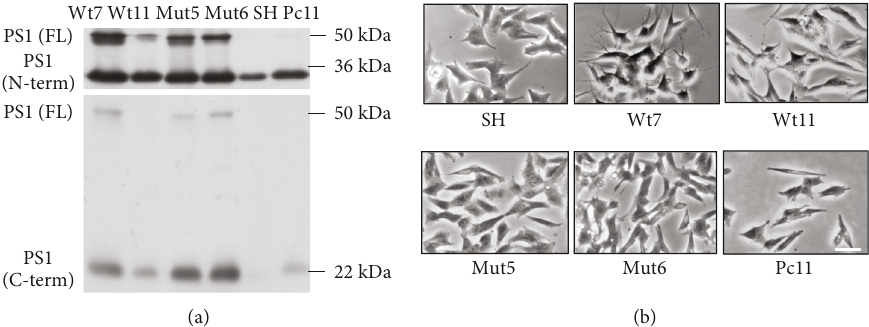
Figure 1: SHSY-5Y cells transfected with plasmid constructs with the presenilin-1 (PS1) gene with the PS1 P117L mutation or not. Some clones with the wild-type (Wt) or the mutated (Mut) PS1 gene were selected and characterized by Western blots (a). The full-length (FL) PS1 protein was overexpressed in the clones compared to the control SH-SY5Y cells (SH) and the clone transfected with the pcDNA3 vector alone (Pc11). FL PS1 is cleaved in two as observed with antibodies against the PS1 N-terminus (N-term) or the C-terminus (C-term). The overexpression was weaker in the Wt11 clone. (b) The Wt and Mut clones could not be distinguished according to their morphological structures, as observed by phase contrast microscopy. Scale bar: 200 μ M.